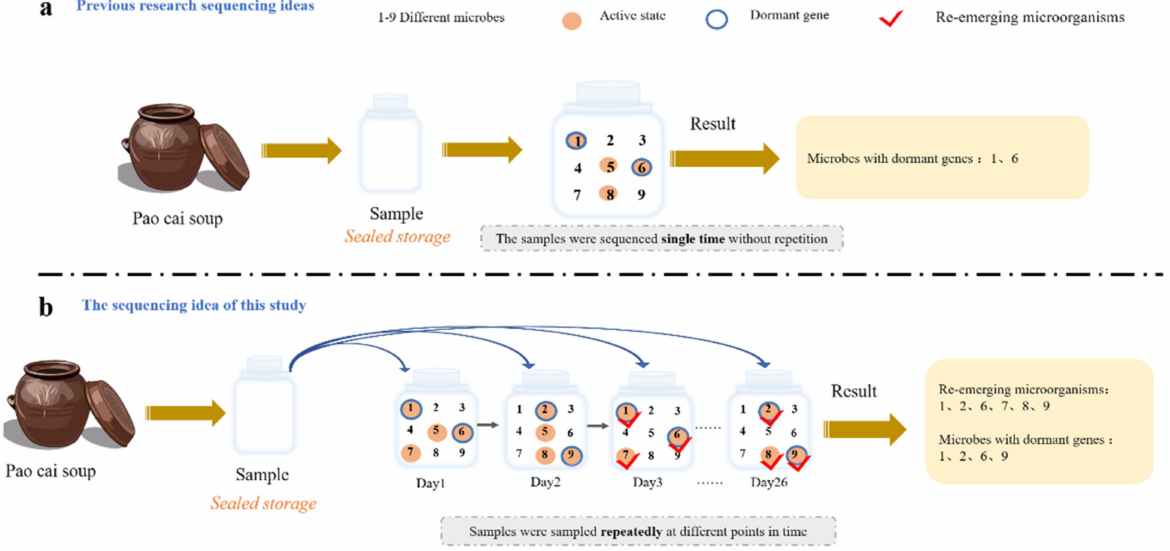
Figure 1. Dormant microorganism identification methods. ( a ) GFP: contains functional genes associated with dormancy in microbial DNA in samples that can be detected by high-throughput sequencing, but only when the microorganism is active and contains dormant genes. ( b ) RAM: multiple sampling and high-throughput sequencing of the original sample, allowing fluctuations in the microorganisms in the sample to be observed over